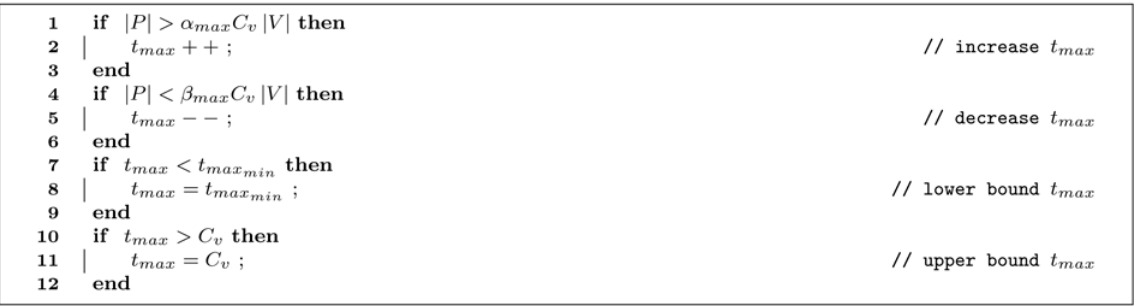
Figure 8. Pseudocode for the self-regulation of t max . The rationale for adjusting t max is very similar to that of Figure 7: it is increased when there are many passengers in the system, it is decreased when there are few, and it is bounded.